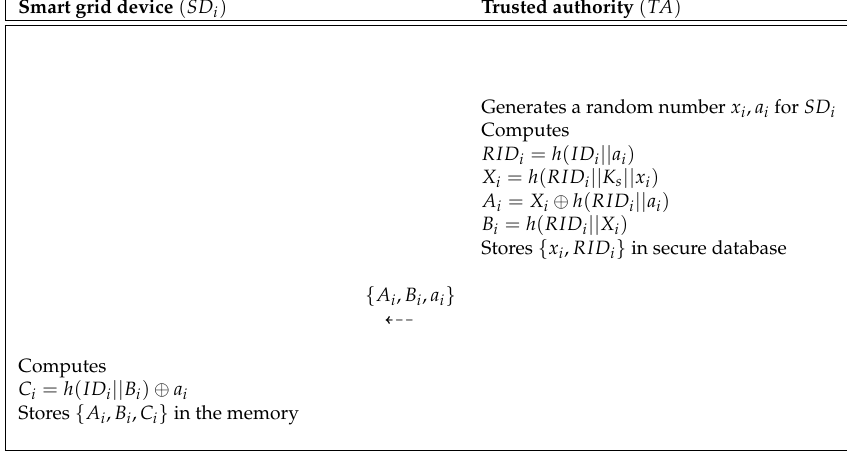
Figure 6. Smart grid device registration process of the proposed scheme.